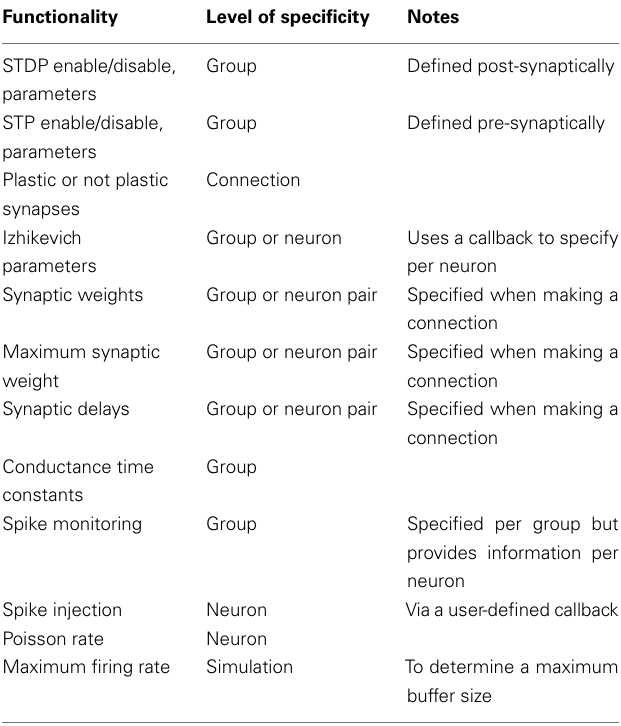
Table 1 | Functionality of the simulation